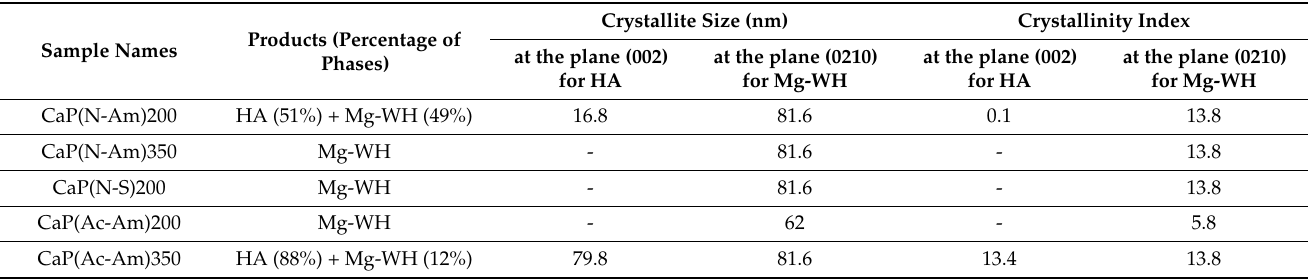
Table 4. Crystallite size and crystallinity index at (002) and (0210) plane for HA and Mg-WH, respectively, including percentage of phases of the products (for the mixed phases) of samples